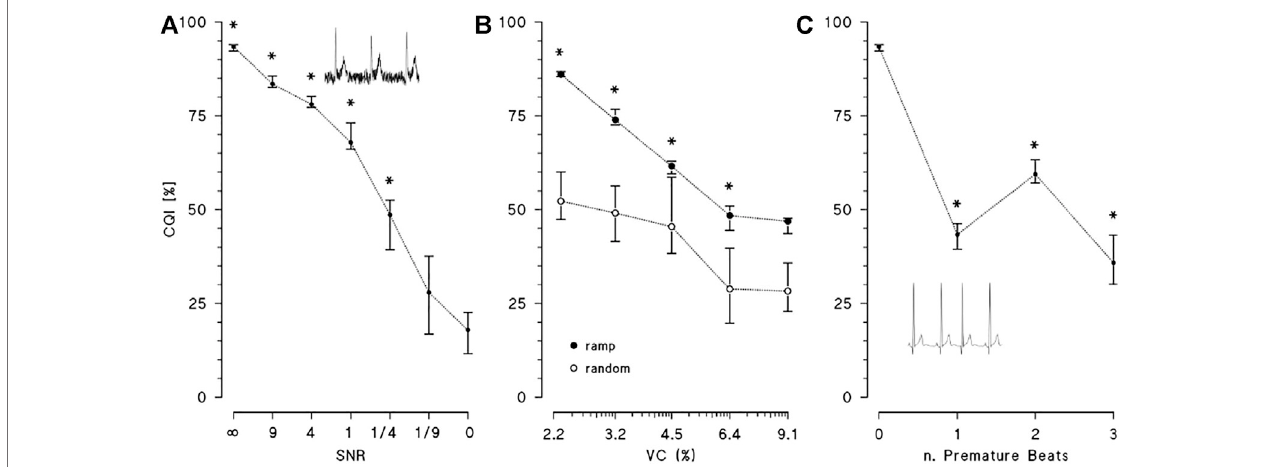
FIGURE 4 | Effects of noise and deviations from periodicity on CQI. CQI median and interquartile range over 8 synthesised ECGs. (A) : CQI at decreasing levels of signal-to-noiseratios,SNR(SNR= ∞ meansnonoise,SNR=0meansnoiseonly)with*indicatingstatisticallysigni fi cantdifferencevs.SNR=0at p < 0.05;theinsetisan example of ECG with SNR = 4. (B) : CQI at increasing values of variation coef fi cient, VC, of R-R interval when the heart rate dynamics consists in monotonic ramps (solid circles)orrandomchanges(opencircles):medianandinterquartilerangeover8synthesisedECGswith*indicatingstatisticallysigni fi cantdifferencebetweenramp andrandomchangesat p < 0.05. (C) :CQIwithoutorwith1,2or3prematurebeats,with*indicatingstatisticallysigni fi cantdifferencevs.noprematurebeatsat p < 0.05: inset is an example of simulated supraventricular premature beat.